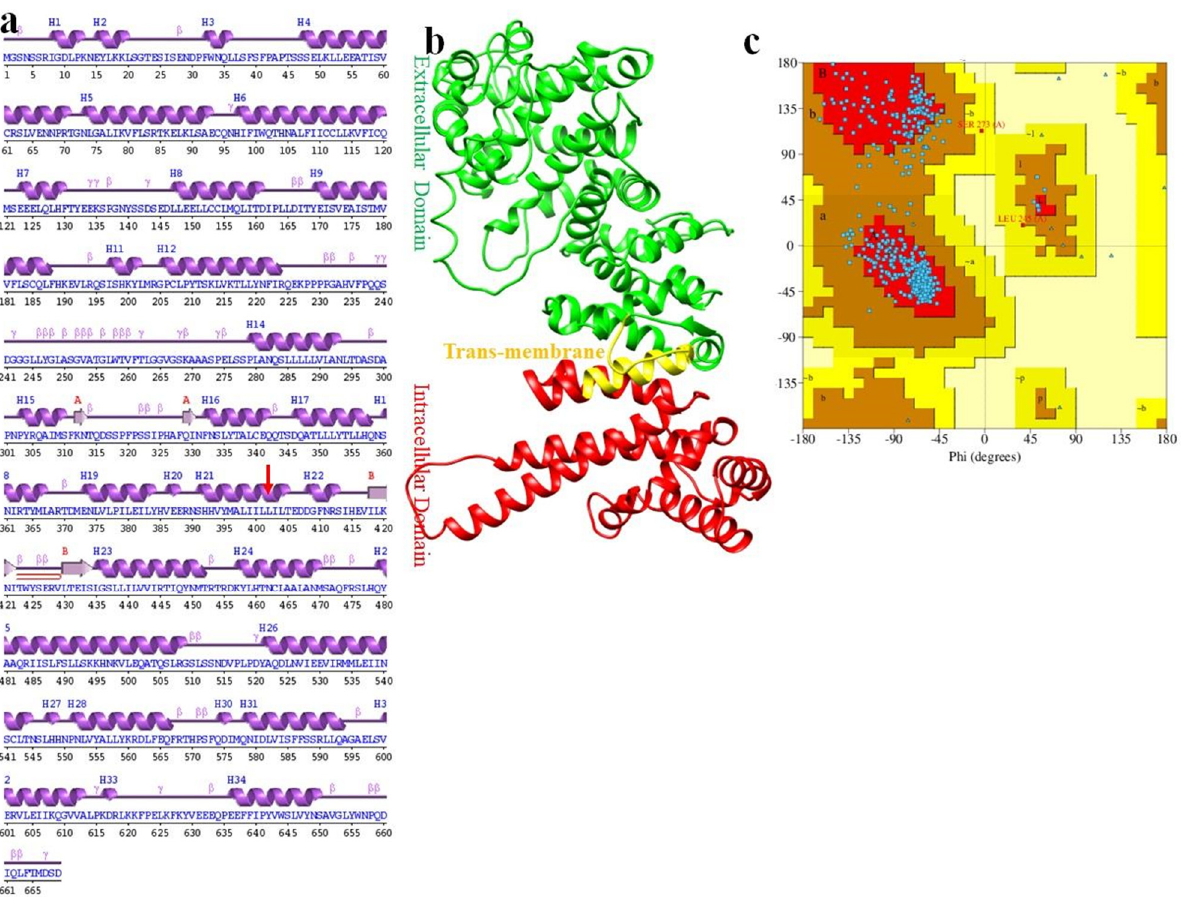
Figure 3. Secondary and tertiary structure of DYM protein. ( a ) Secondary structure of DYM with mutation position shown in red arrow. Sheets and helices are shown in purple color and β turns are shown in red. ( b ) Tertiary structure of DYM in ribbon representation. Different domains are shown in their respective colors.( c ) Ramachandran plot of DYM tertiary structure.